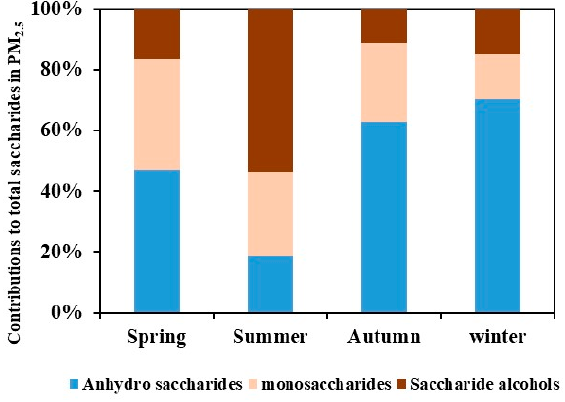
Figure 3. Contributions of the three typical saccharides in PM 2.5.